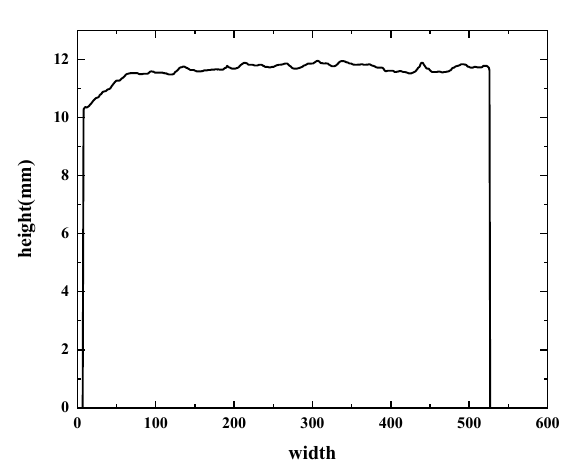
Figure 4. Example of a scanned cross-sectional image of a fish body. The volume between two consecutive sections (unit: mm 3 ) is calculated as follows: